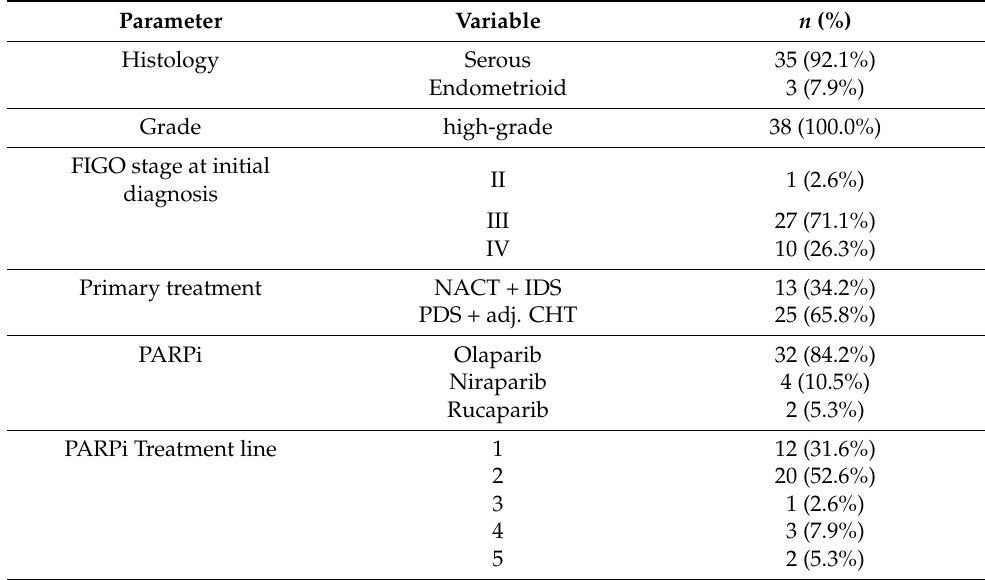
Table 1. Patient characteristics at primary diagnosis of 38 patients with tumor cellularity >10%.